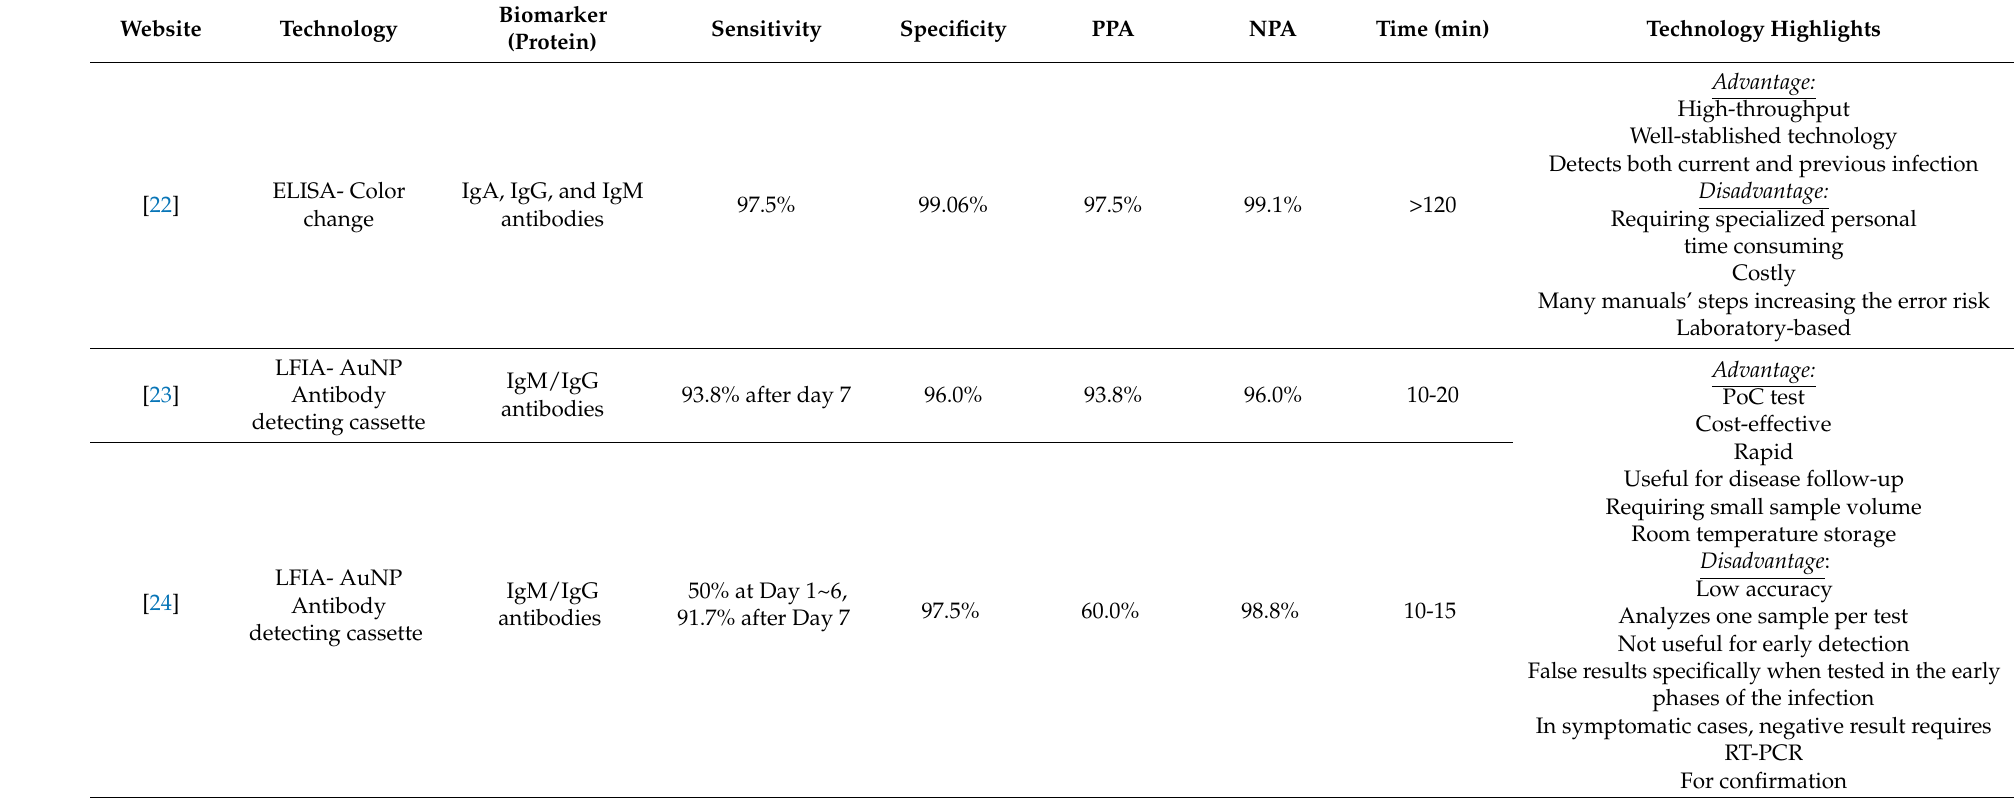
Table 1. FDA EUA-approved protein-based assays for SARS-CoV-2